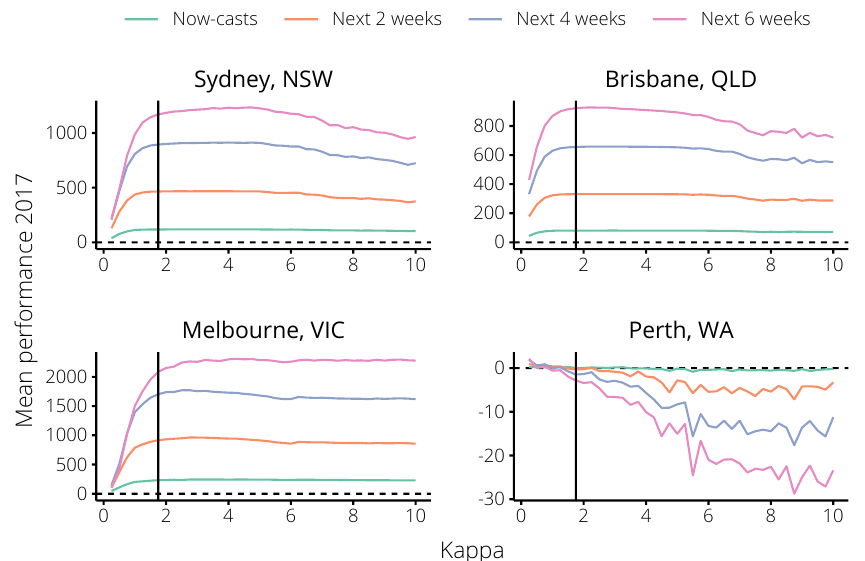
Figure 7. The trends in mean forecast performance (cid:101) b k over the 2017 influenza season for each city, relative to the non-calibrated forecasts (the horizontal dashed line); (cid:101) b k > 1 indicates substantial performance improvement, and (cid:101) b k < − 1 indicates substantial performance reduction. The black vertical line indicates κ = 1.75, the value chosen as optimal based on the 2014–2016 seasons.